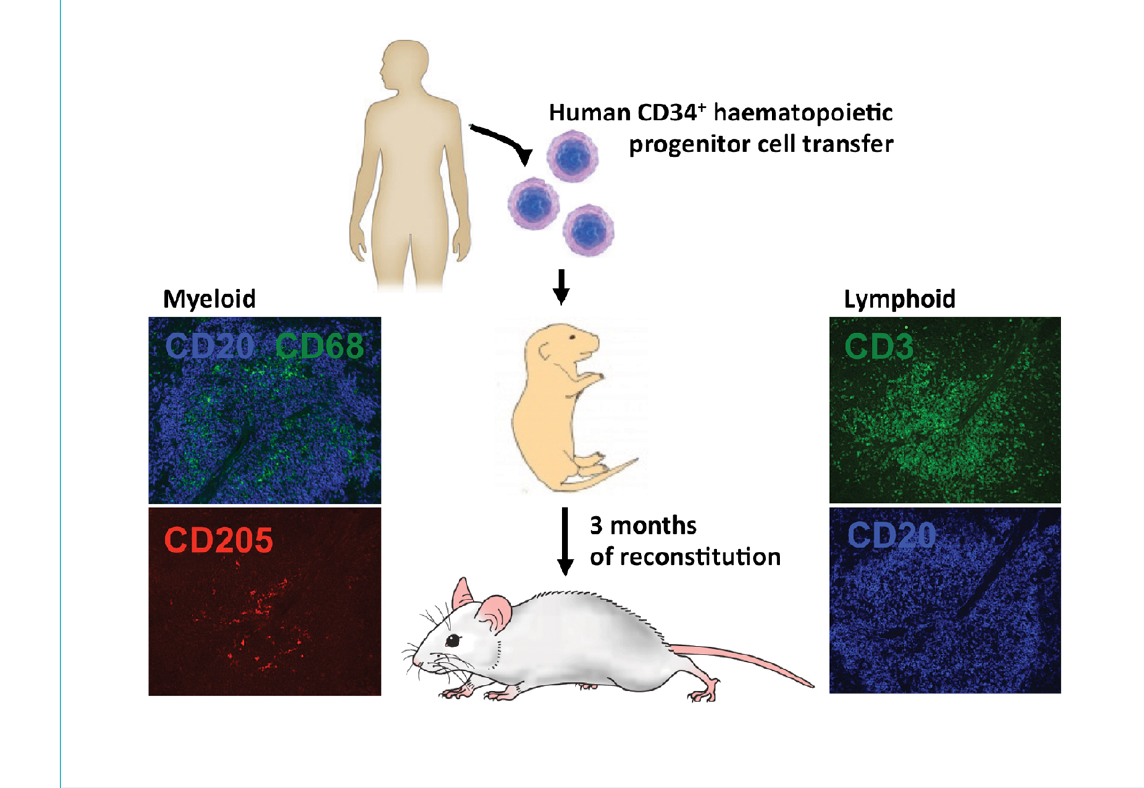
Figure 5: Human immune compartments of HIS mice. HIS mice reconstitute most human immune compartments within 3 months after neonatal intrahepatic human CD34 + haematopoietic progenitor cell transfer. In the spleen of NSG mice, macrophages (CD68), dendritic cells (CD205), T cells (CD3) and B cells (CD20) can be found in the white